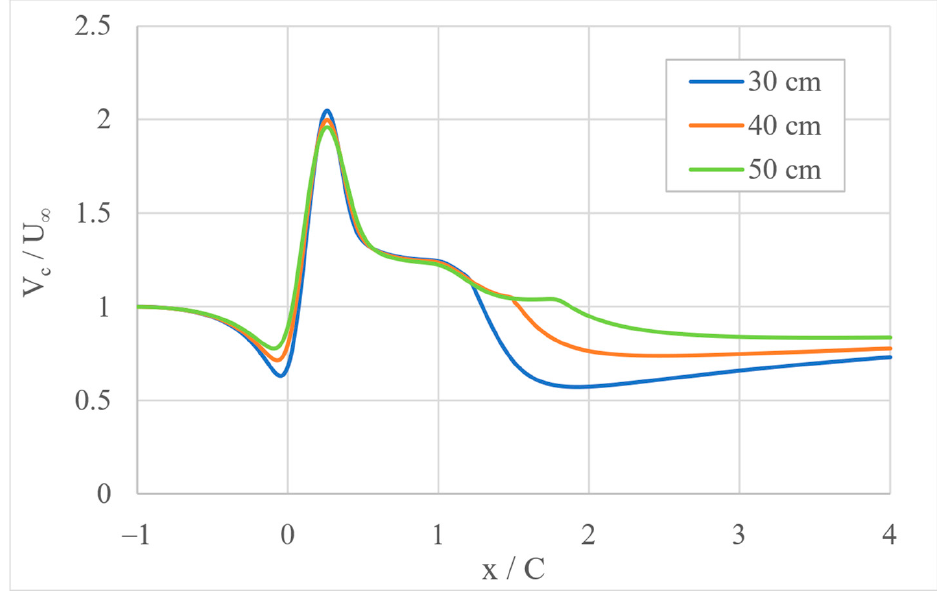
Figure 9. Center line velocity change along the augmentation system with different gaps and ( U ∞ = 5 m/s, +5° pitch angle).